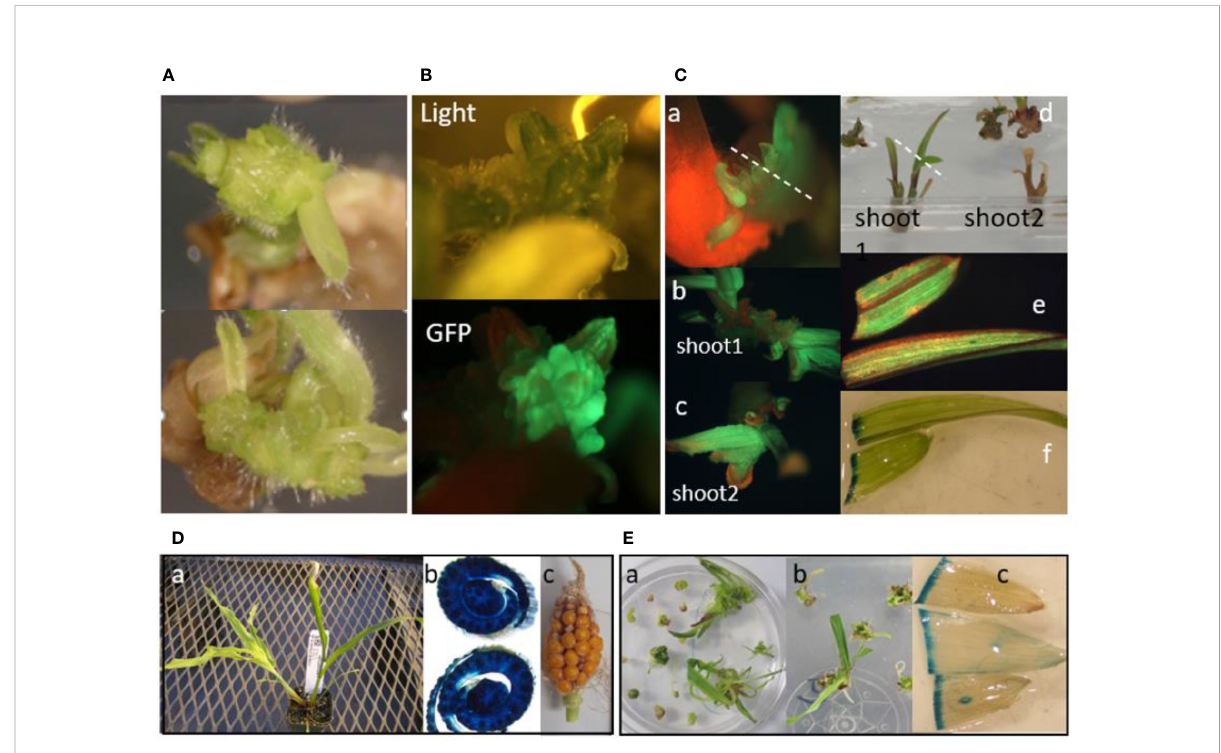
FIGURE 3 Multiple bud induction and direct transformation of maize SEEs for transgenic plant regeneration on high cytokinin medium CMSI-18. (A) Multiple bud formation from 2 individual SEEs after 3 weeks on CMSI-18 without selection; (B) A bud expressing GFP was selected on CMSI-18 with 75 mg/L paromomycin for 60 days after co-culture, whole clump is about 1 cm in diameter; (C) GFP-expressing multiple buds from maize SEEs direct transformation using streptomycin selection in CMSI-18. a: Multiple bud formation after 5 weeks on streptomycin selection medium, dot line indicates cutting into 2 buds for elongation of shoot 1 b: and shoot 2 (c), d: Two GFP positive shoots in rooting medium, dotted line indicates samples for GFP observation (e) and GUS staining (f); (D) A transgenic shoot from paromomycin selection in CMSI-18. a: the shoot in soil, b: GUS staining of transverse section of the old stem, c: ear recovered from feminized tassel of transgenic shoot in a; (E) A glyphosate resistant shoot from direct transformation of SEEs. a: 7 weeks after inoculation and selected on hormone-free medium 1083 with 20 mM glyphosate, b: the rooting shoot on the same media, c: GUS-stained leaves from the shoots in